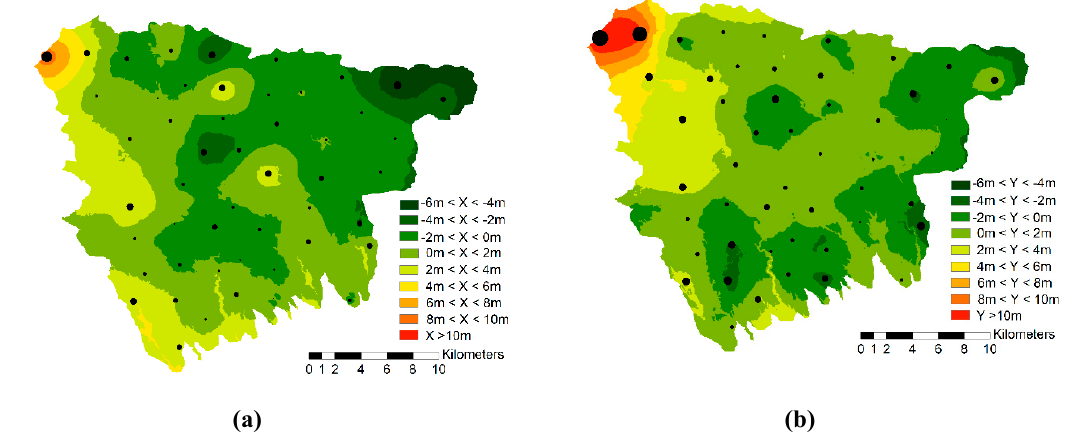
Figure 9. Error maps along the two axes. ( a ) Error X; ( b ) error Y. The black points indicate the 50 GCP dataset. The size of each point represents the error value; the larger points correspond to higher error values.